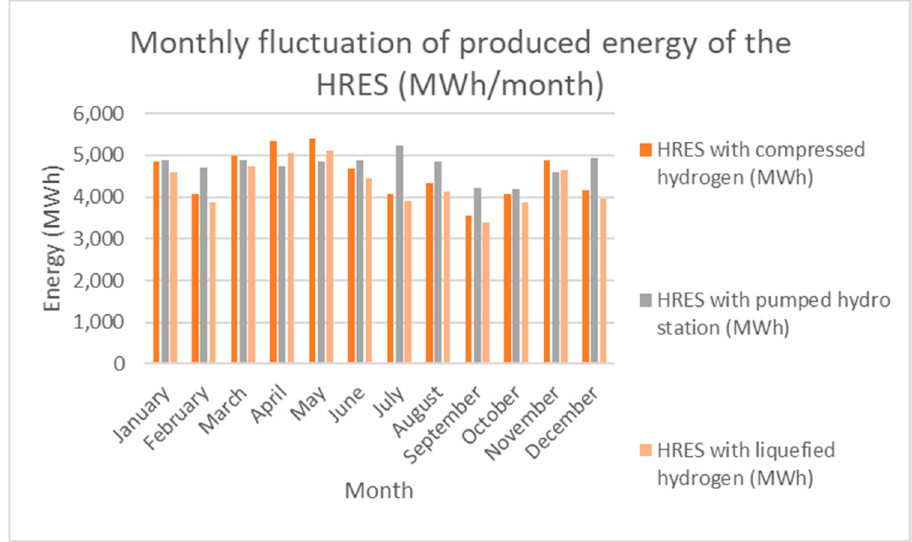
Figure 17. Monthly fluctuation of produced energy of the HRES.